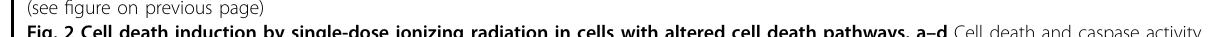
We tested the effect of increasing IR doses on four cancer cell lines from different origins: CT26 colon carcinoma,